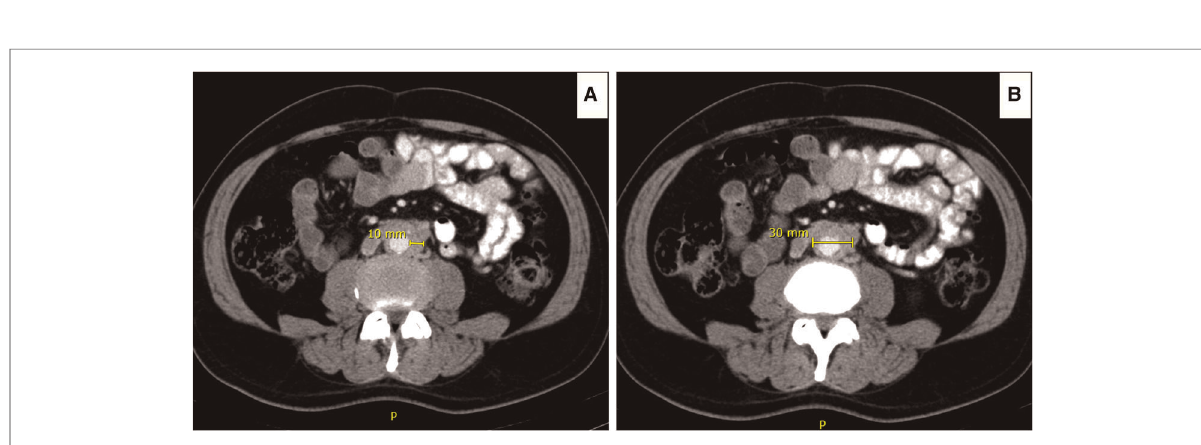
FIGURE 2 Computed tomography angiography (CTA) images illustrating the determination of the aortic retroperitoneal fi brosis index (peri-aortic soft tissue enhancement over maximum aortic diameter). ( A ) Peri-aortic soft tissue enhancement of 10 mm. ( B ) overall aortic enhancement of 30 mm, including the peri-aortic soft tissue